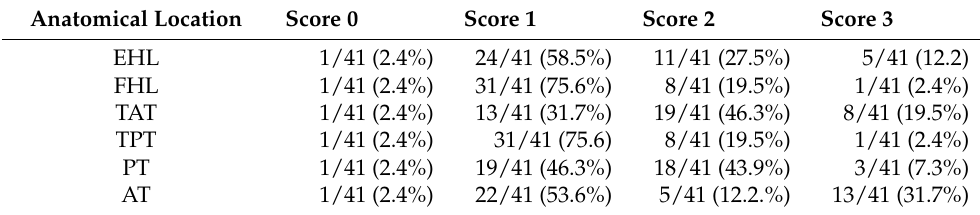
Table 3. Scoring of MSU deposits in foot tendons of embalmed cadavers.